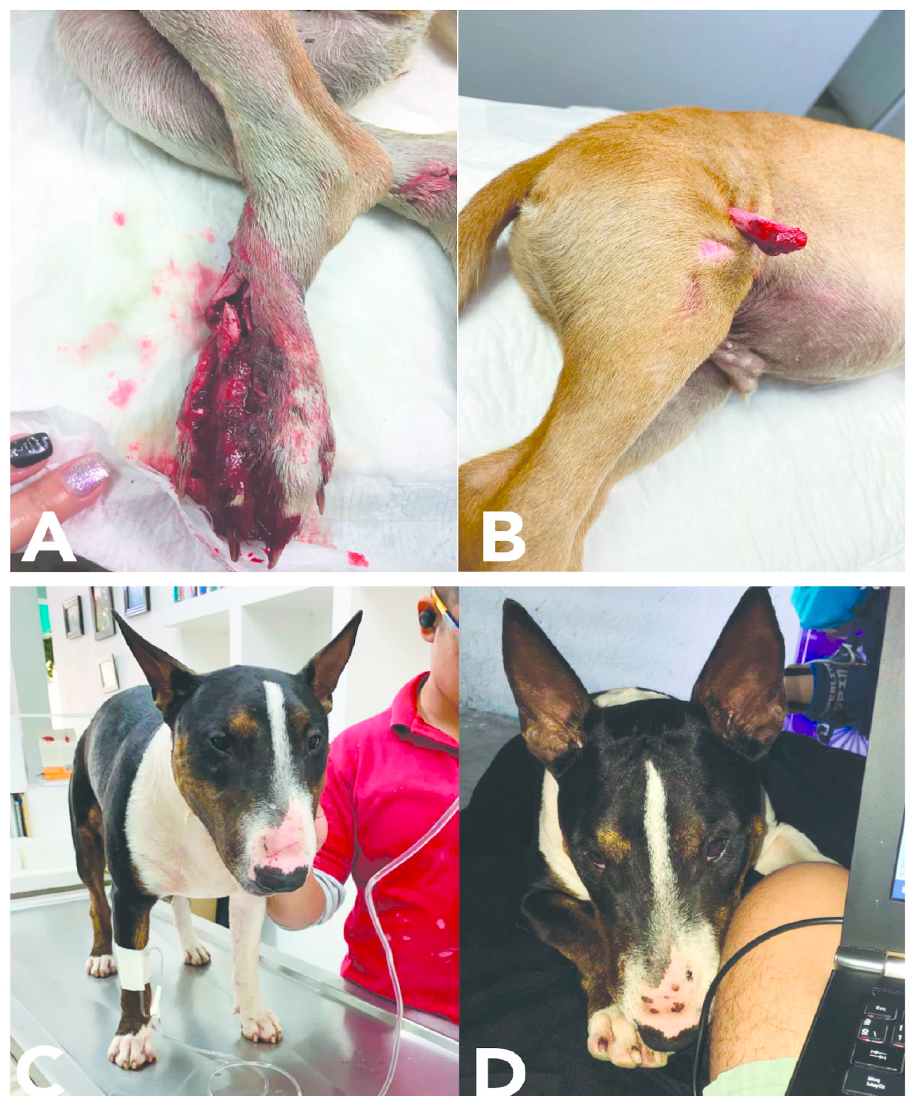
Figure 2. Diverse lesions caused by fights with conspecifics. ( A ) A severe wound in the foot of the left pelvic limb of this patient after a fight with a Rottweiler. The site shows exposed bone (metatarsals, phalanges) and ligaments and the loss of tissue continuity with multiple exposed fractures. ( B ) Image of an exposed fracture of the distal portion of the femur caused by a fight with a stray dog. ( C , D ) Images of an English Bull Terrier brought for examination with diverse lesions caused by a spontaneous fight with a stray dog. There are evident scratches and penetrating bites in the muzzle, nasal plane, and left thoracic limb.